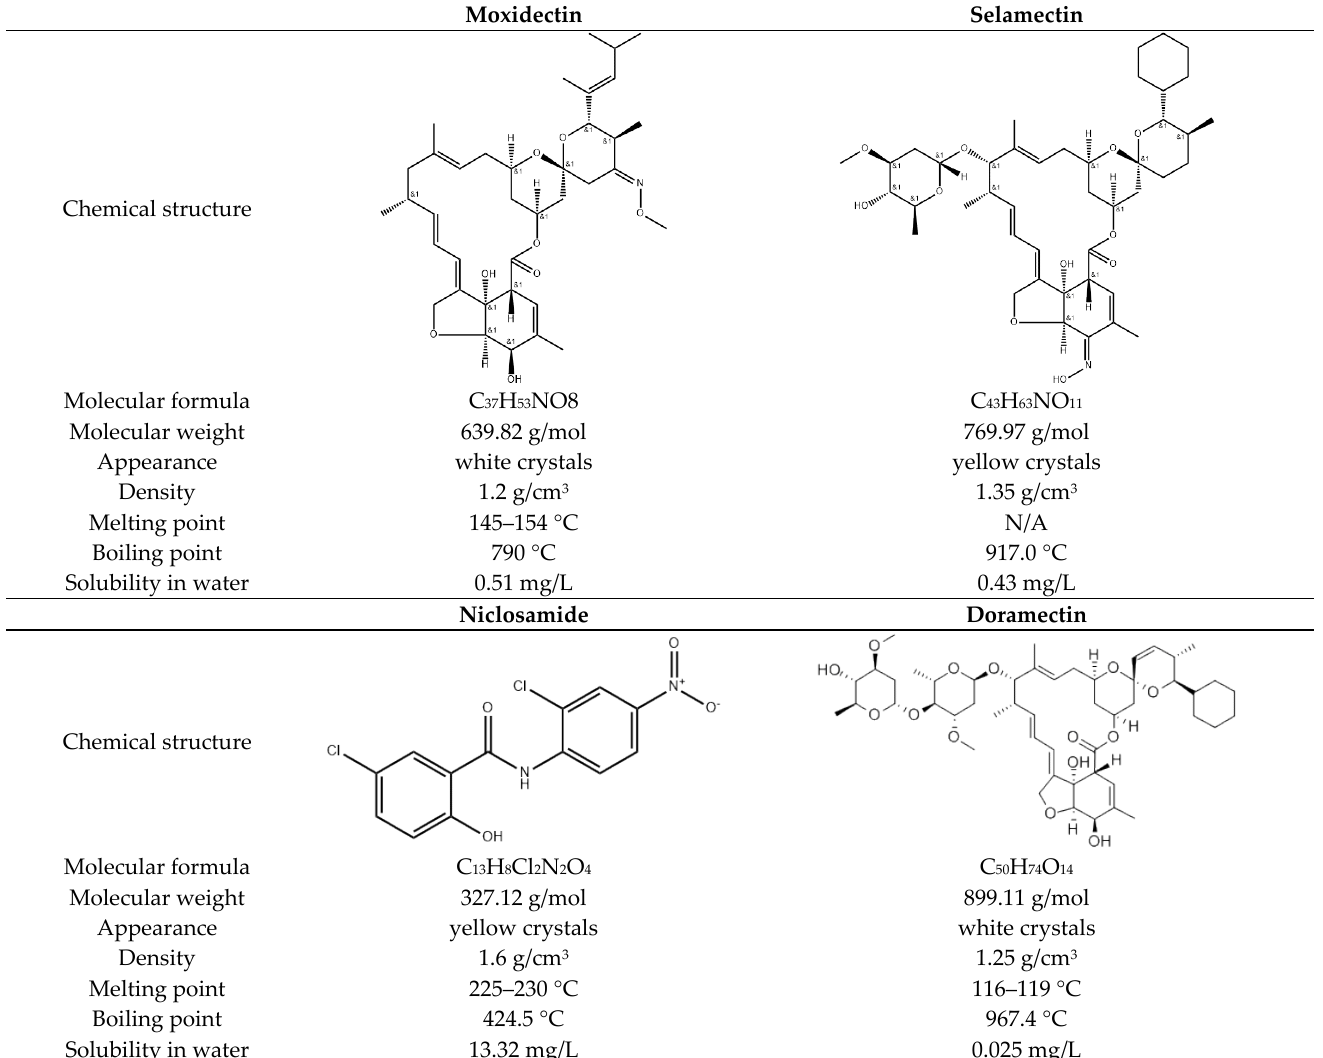
Table 2. Chemical structure and molecular properties of moxidectin, selamectin, niclosamide and